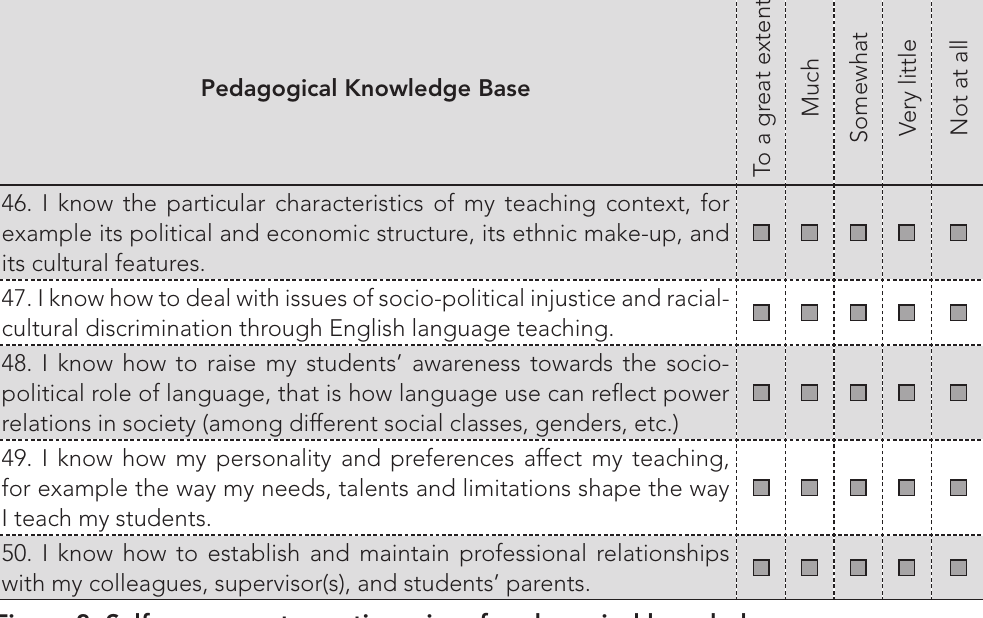
Model evaluation